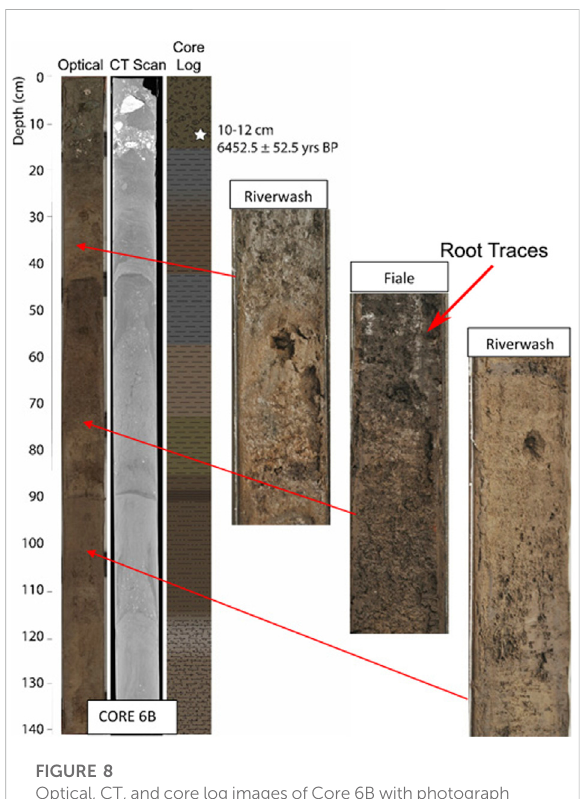
FIGURE 8 Optical, CT, andcore log images ofCore6Bwith photograph insets of two Riverwash (Fluvent) and one Fiale (Xerept) paleosol. White star on core log shows location of radiocarbon sample and depth and age are noted. Red arrow shows location of paleosol. Distinct root traces are noted in the